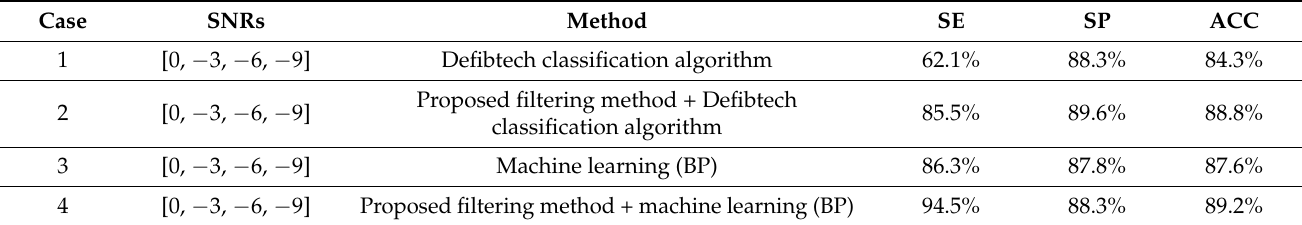
Figure 9. ( a – d ) represent results of two rhythm analysis algorithms on different corruption levels before and after applying the proposed filtering approach. Table 5. Averaged results on different SNR levels.